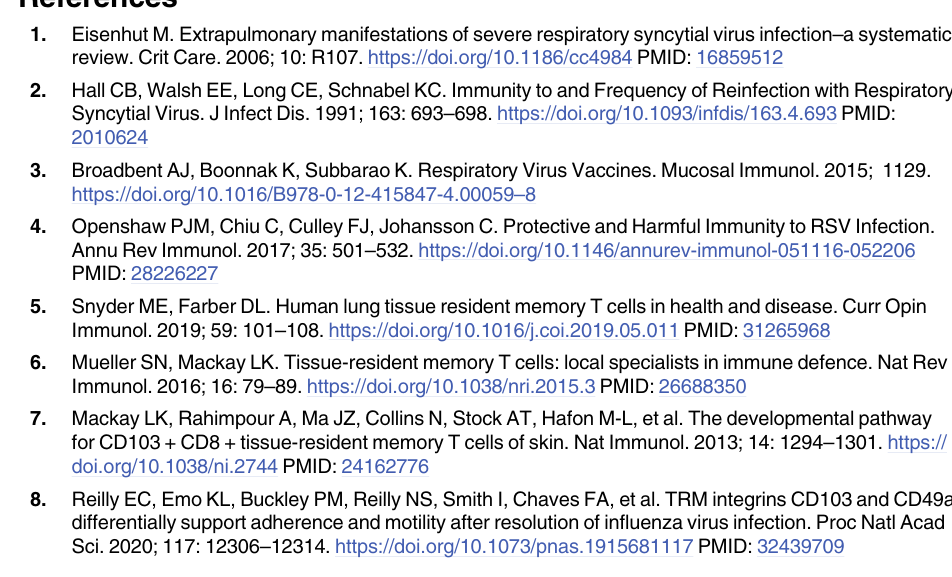
S1 Table. Antibodies and other reagents used for flow cytometry for the murine studies.